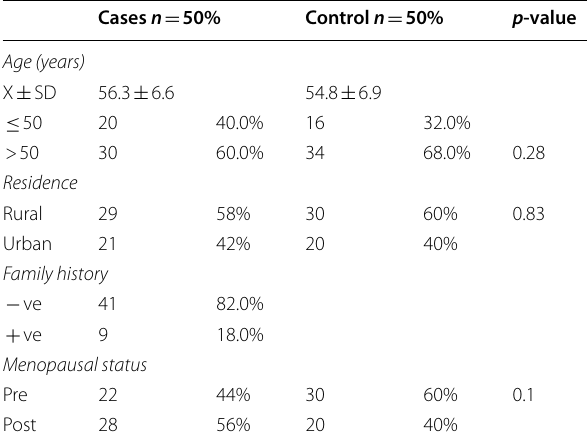
Table 1 Risk factors and demographic data of controls and ovarian cancer patients